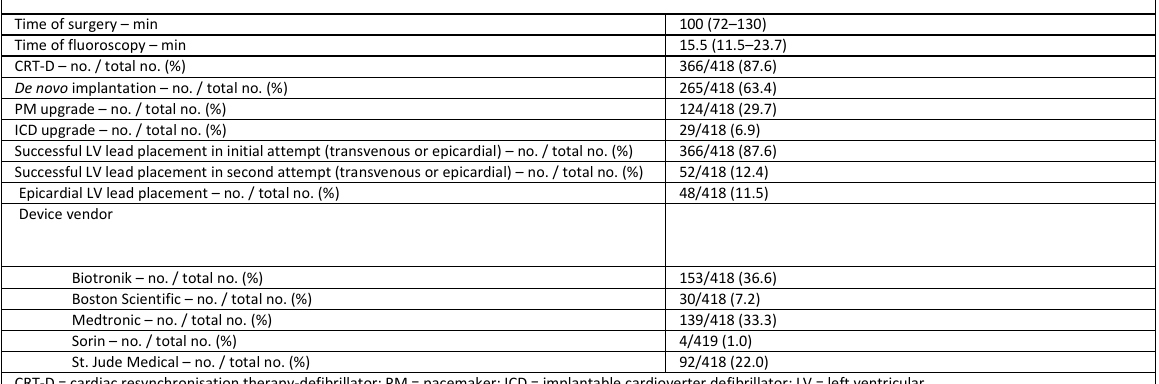
Table S5A : Perioperative characteristics and devices.